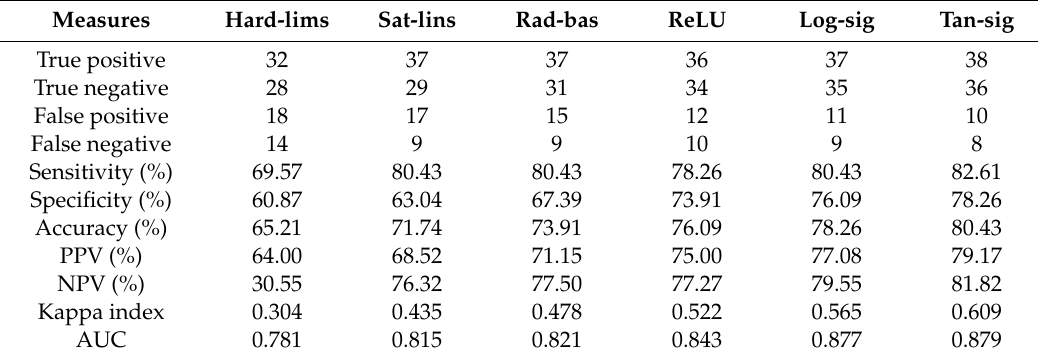
Table 5. Results of model performance